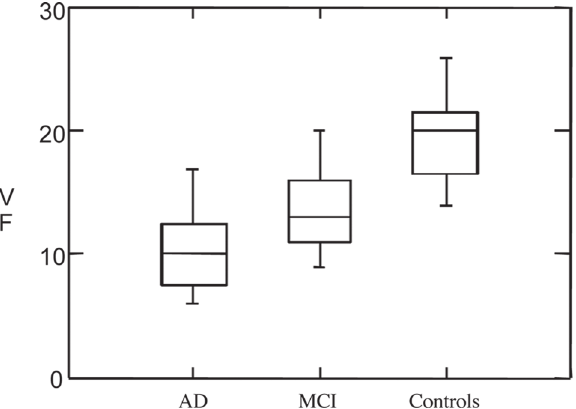
Figure 1. Distribution of verbal fl uency scores of AD, aMCI and control